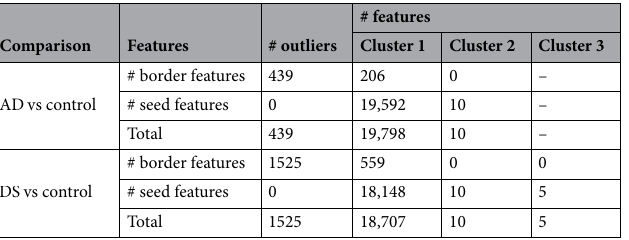
Table 1. Summary of DBSCAN clustering for outlier (noisy feature) removal prior to statistical test. AD Alzheimer’s disease, DS Down